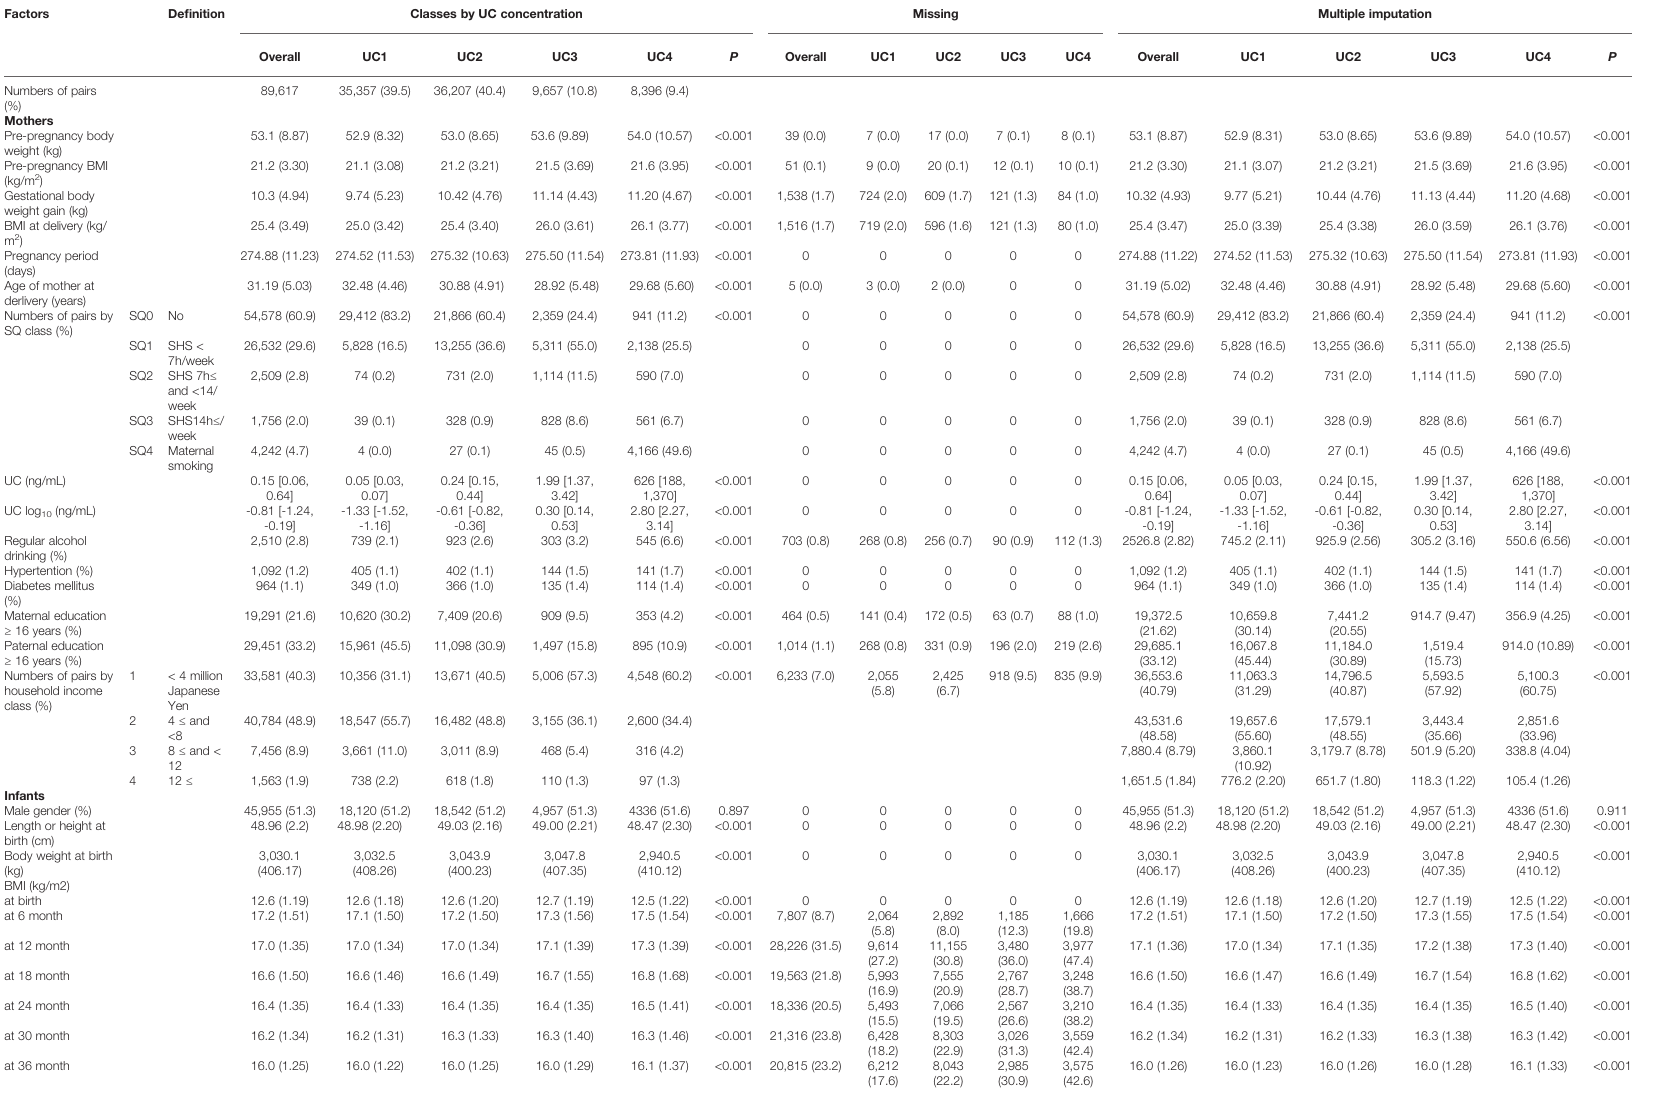
TABLE 3 | General characteristics of 89,617 participants in classes by urine cotinine (UC) concentration before and after multiple